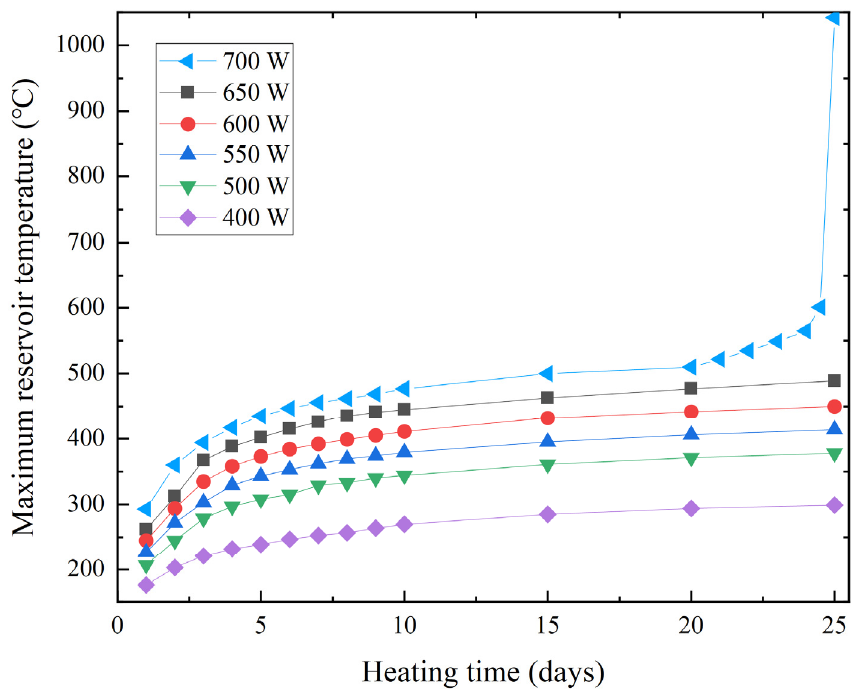
Figure 7. The maximum reservoir temperature of oil shale under different microwave power levels for 25 days. for 25